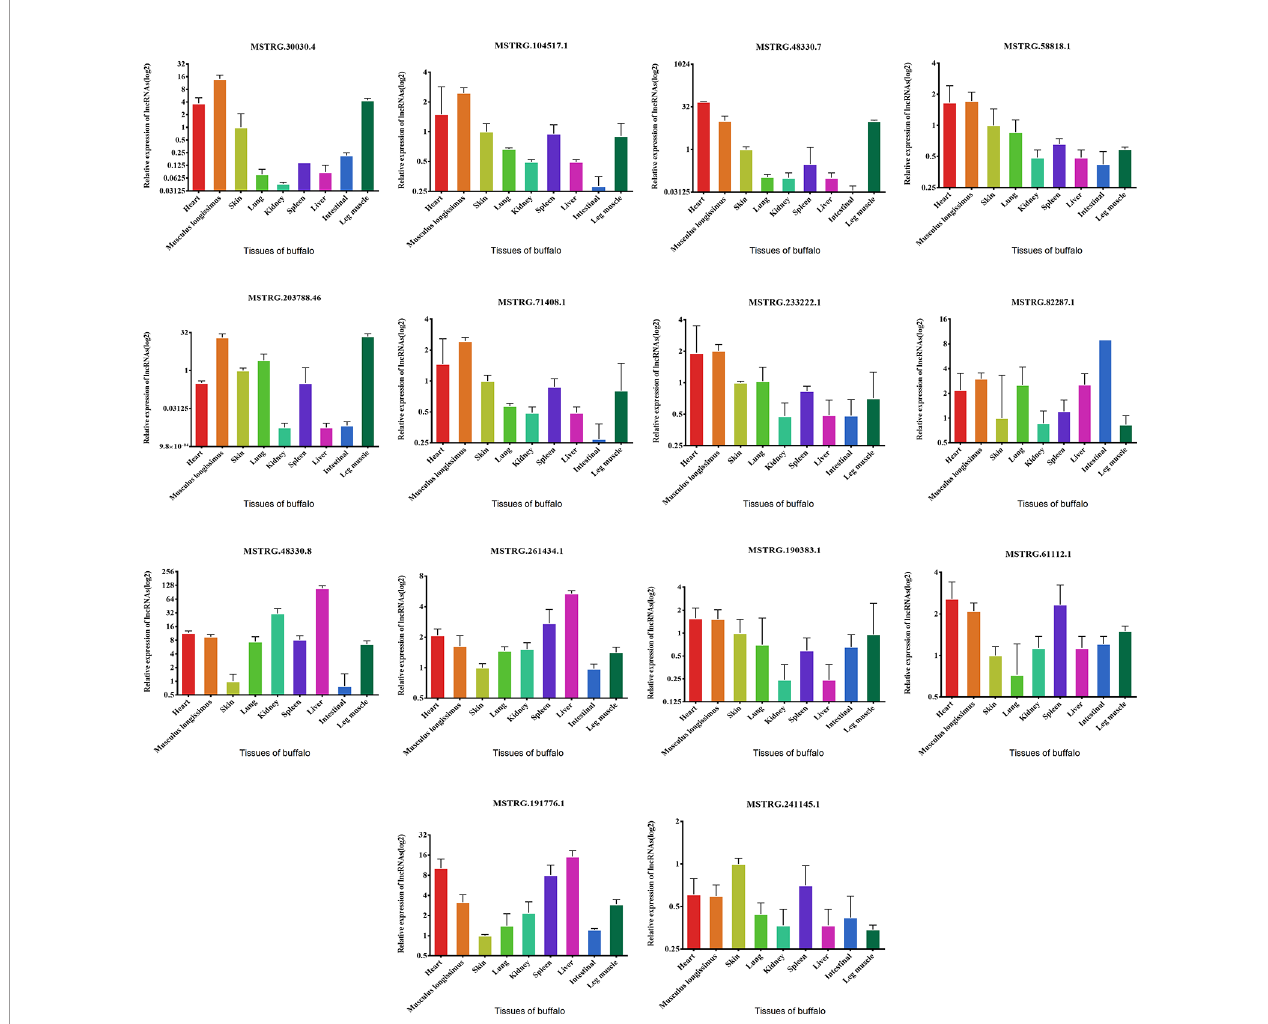
FIGURE 7 | Expression levels of 14 candidate lncRNAs in different tissues of fetus